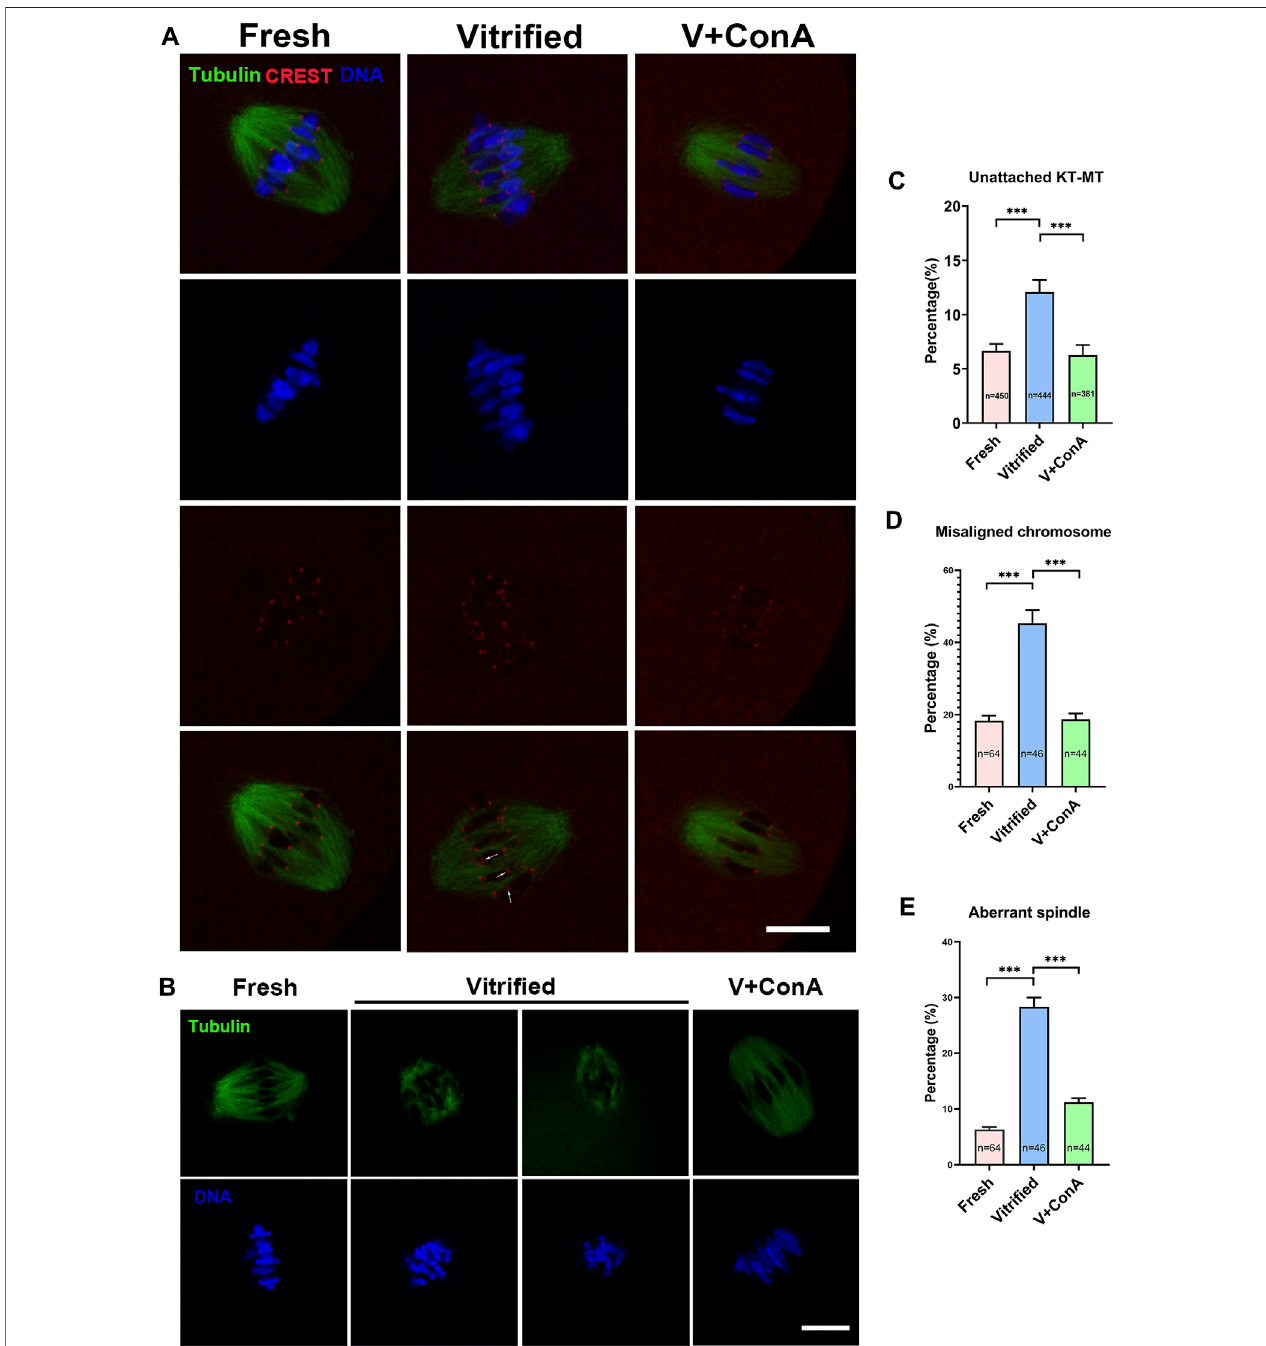
FIGURE 8 | Increasing cortical tension regulated microtubule dynamics during chromosome segregation. (A) KT-MT attachment in different groups at 6 h after GVBD.White arrows indicatenonconnectedkinetochores. Scale bar =25 μ m. (B) Representativeimages ofspindle morphologies and chromosome alignmentinfresh, vitri fi ed, and V + ConA oocytes at 6 h after GVBD. Scale bar = 25 μ m. (C) The rate of unattached KT-MT in the fresh ( n = 450), vitri fi ed ( n = 444), and V + ConA ( n = 381) groups. (D) Therateofmisaligned chromosomeinthefresh( n =64),vitri fi ed( n =44),andV+ConA( n =46)groups. (E) Therateofaberrantspindleinthefresh( n = 64), vitri fi ed ( n = 44), and V+ ConA ( n = 46) groups. Datawerepresented asmean percentage (mean ±SEM) ofat least three independent experiments. * p < 0.05, ** p < 0.01, *** p < 0.001.